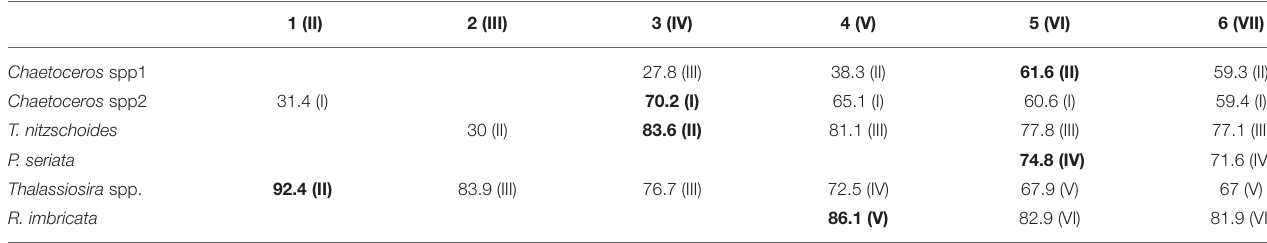
Each column represents a clustering level (number), given a number of assemblages (roman number). Indicator values are obtained for the successive hierarchical clustering levels from level one (two assemblages, I and II) to level six (seven assemblages, I to VII). For a species at a specific clustering level (a particular case of the table), IndVal is displayed as well as their attributed assemblage (indicated by the roman number between parentheses). Only indicator values greater than 25% and significant (p-value < 0.05) were displayed (according to Dufrêne and Legendre, 1997). The results for the six most abundant species are displayed in the Table for clarity, which are the six species for which the Indicator Value was significant. Bold values identify the highest IndVal observed among clustering levels for each dominant species.